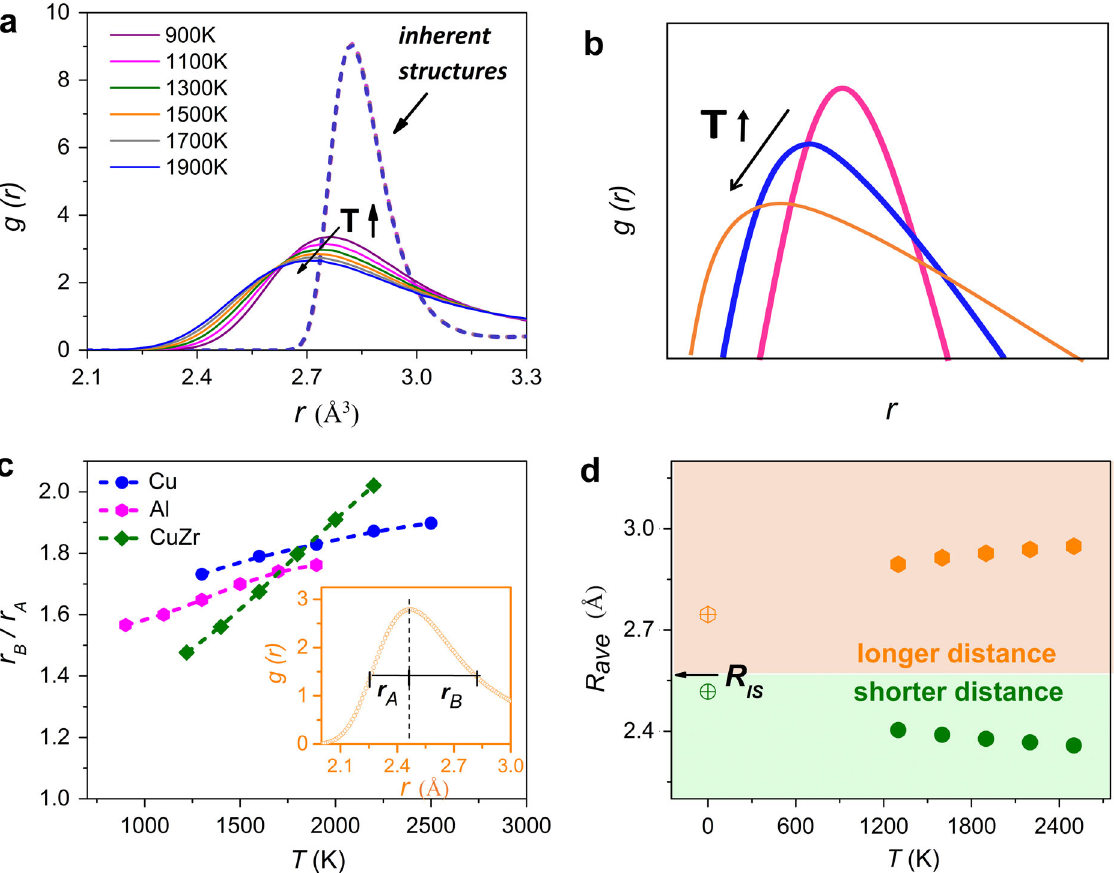
Fig. 5 Asymmetric fi rst peak in the g ( r ) of metallic liquids. a g ( r ) of constant-density Al liquids and corresponding inherent structures at various temperatures; b Schematic illustration of the asymmetry of the fi rst g ( r ) peak, and the skewness increases upon heating; c Evaluation of r B / r A as the asymmetry of the fi rst peak in g ( r ) at various temperatures for Cu, Al and Cu-Zr liquids (constant density). The de fi nition of r B and r A are schematically shown at the full width of half maximum of the fi rst peaks in the inset. d Average interatomic distance for atom pairs with shorter distance and longer distance in Cu melts at various temperature; (i.e., negative and positive departure from R IS , the fi rst peak position in g ( r ) for the inherent structure). Adapted from ref.